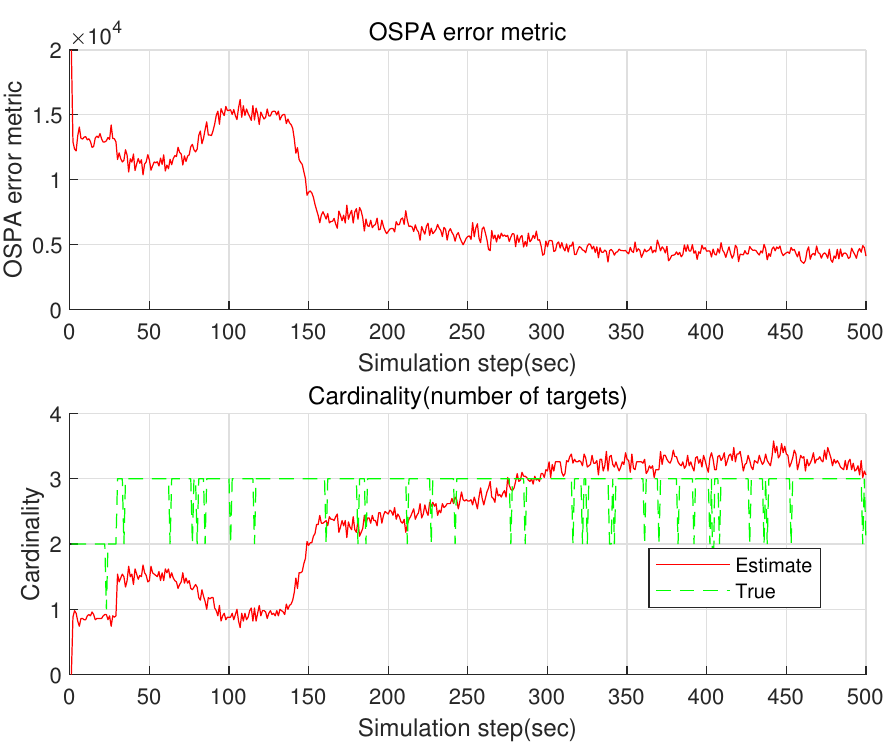
Figure 6. The OSPA and the cardinality of the proposed GM-PHD in the case where B = 10 is utilized.